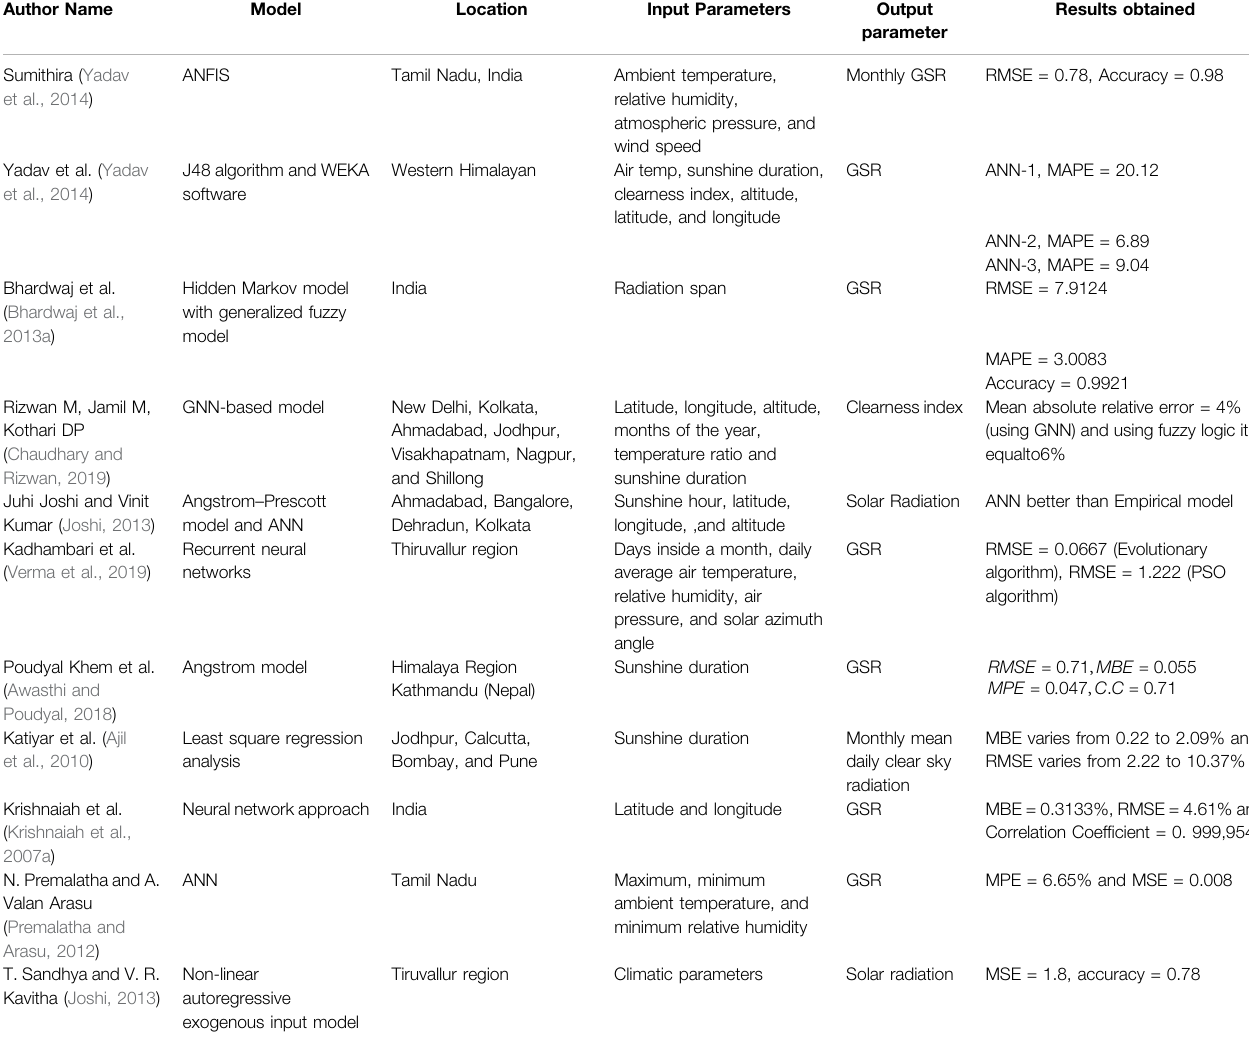
TABLE 5 | Performance evaluation of different models with respect to number of